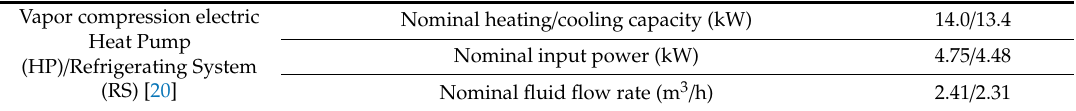
Table 3. Characteristics of the sensors used for the AHU monitoring. Model